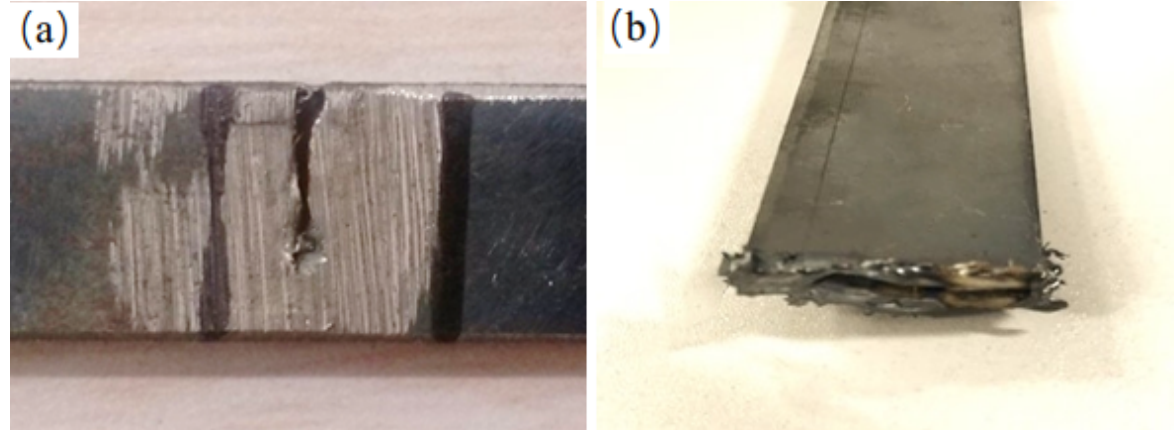
Figure 1. Defects in the welded joint of test steels. ( a ) Incomplete Fusion Defects caused by low current; ( b ) Melting defect caused by excessive